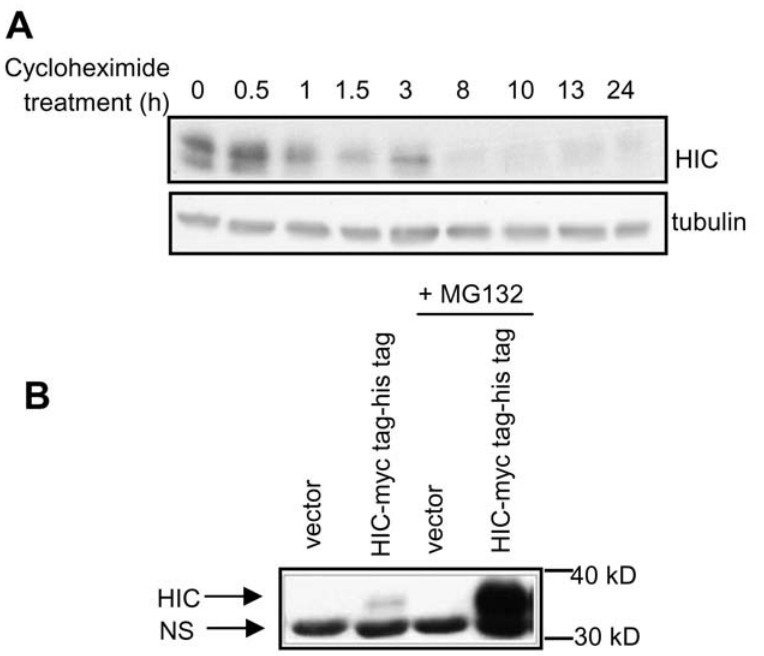
Figure 5. Ectopically expressed HIC protein has a short half life and is degraded by the proteosome. A. HEK-293 cells were transfected with a plasmid encoding HIC-myc tag (pcDNA3 HIC-myc tag-his tag). 24 h after transfection cells were treated with 100 m M cycloheximide for the indicated time periods and lysates analyzed by Western blots using anti-myc or anti-tubulin antibodies. B. HEK-293 cells were transfected with an empty vector or myc tagged HIC without or with addition of the proteosome inhibitor MG132 for 18 h. Lysates were analyzed by Western blot using an anti-myc antibody. 30 kD and 40 kD size markers are indicated. Arrows point to the HIC protein (HIC) and a non-specific band (NS).